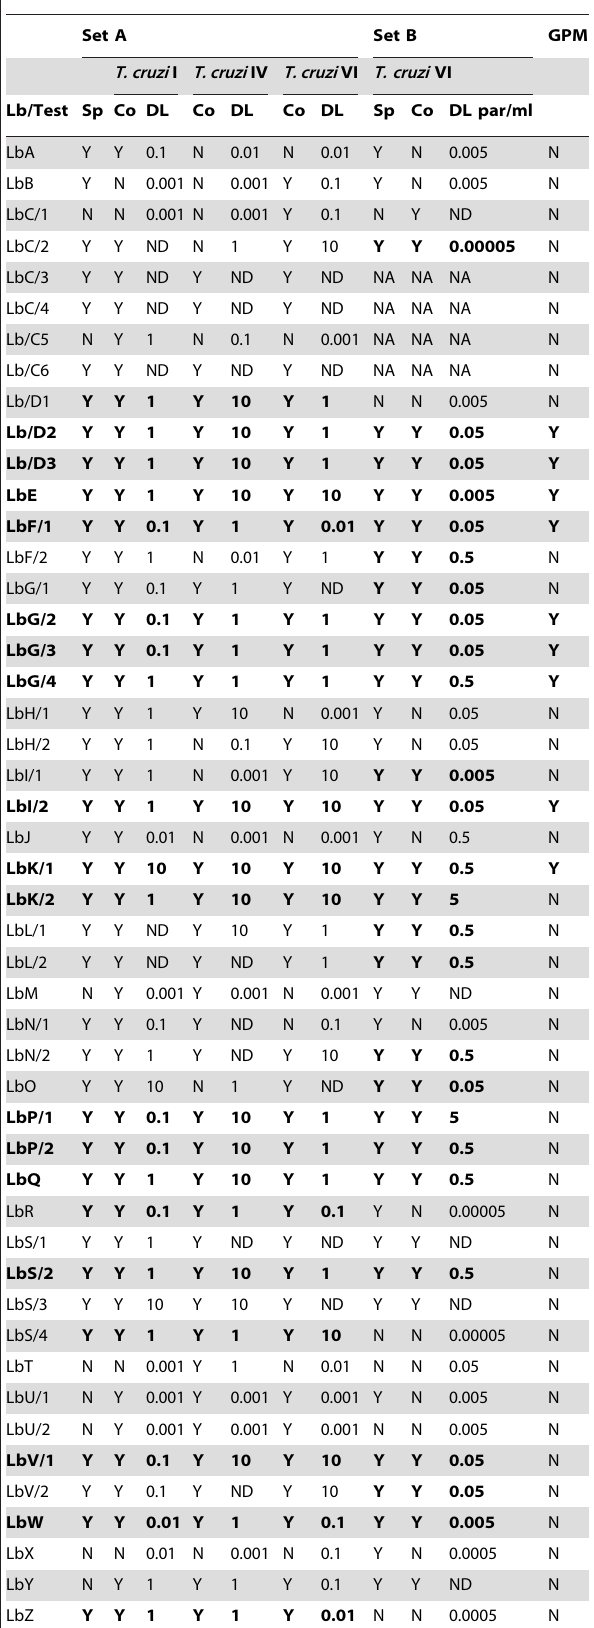
Table 2. Performances of PCR tests in Sets A and B.